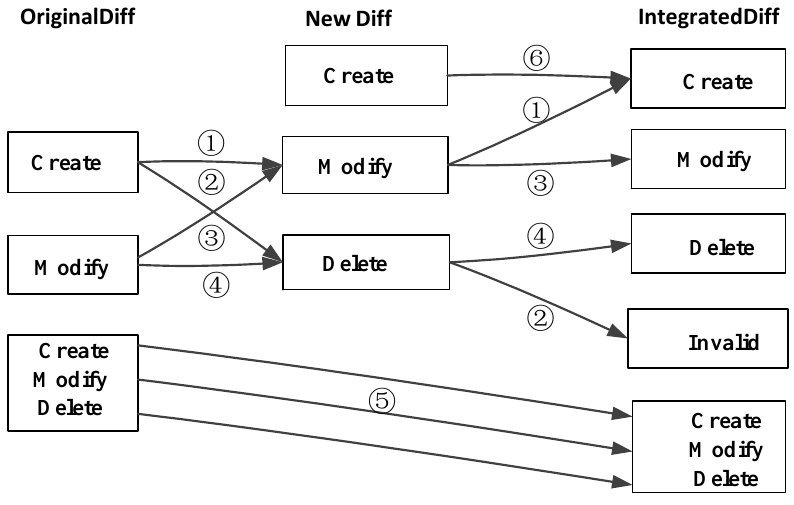
Figure 5. Change-type evolution of the objects between the neighbor